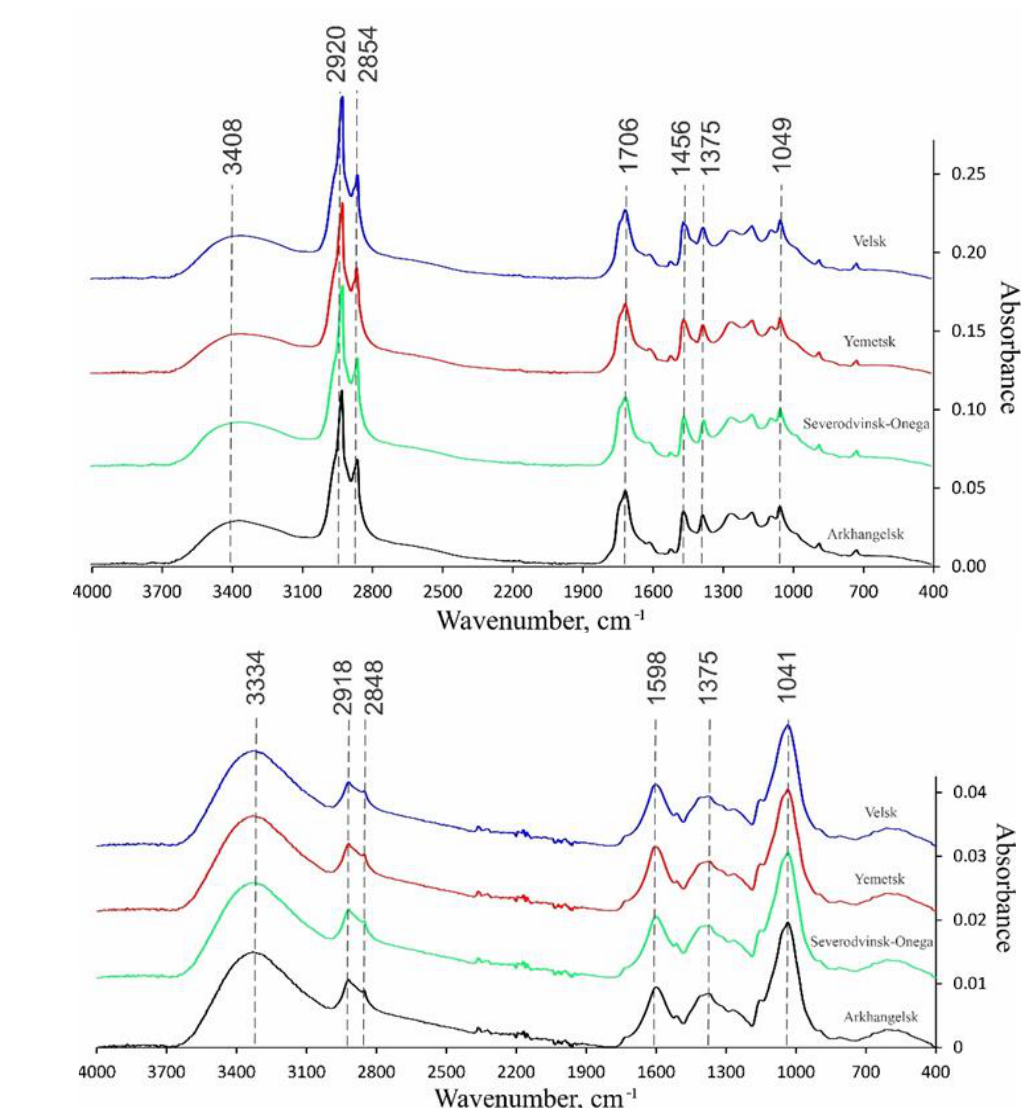
Figure 3. IR spectra of (a) the bitumen samples and (b) the humin